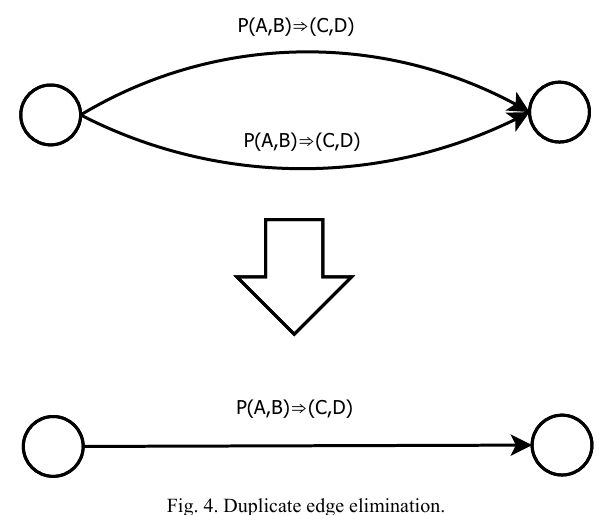
Fig. 4. Duplicate edge